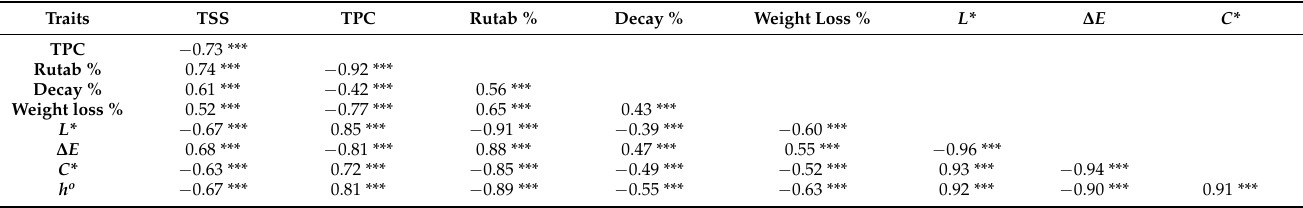
Table 4. Pearson’s correlation coefficients between some biochemical and physical characteristics of ‘Khesab’ fruit.